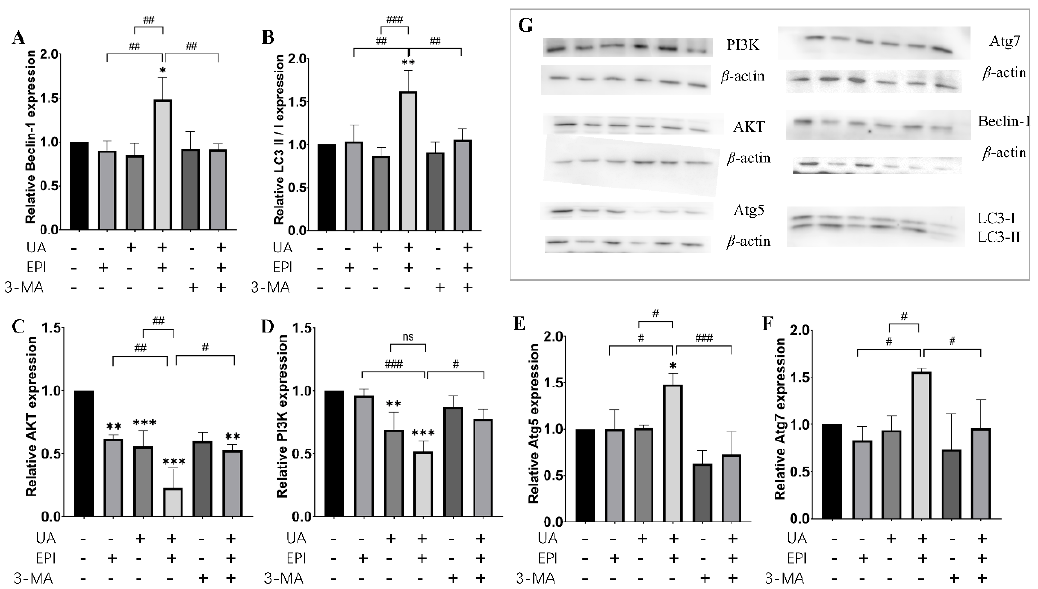
Figure 7. Changes in the expression levels of autophagy-related protein in MDA-MB-231 cells. West- ern blot analysis was used to measure autophagy-related protein expression levels in MDA-MB-231 cells. ( A ) Quantification of Beclin-1 protein expression levels in MDA-MB-231 cells. ( B ) Quantification of LC3-II/I protein expression levels in MDA-MB-231 cells. ( C ) Quantification of AKT protein expression levels in MDA-MB-231 cell. ( D ) Quantification of PI3K protein expression levels in MDA-MB-231 cells. ( E ) Quantification of Atg5 protein expression levels in MDA-MB-231 cells. ( F ) Quantification of Atg7 protein expression levels in MDA-MB-231 cells. ( G ) Representative pictures of Beclin-1, LC3-II/I, AKT, PI3K, Atg5, Atg7 expression by Western blot. The means and SEM were shown. n = 3. * p < 0.05, ** p < 0.01 and *** p < 0.001 versus control group in the absence of any treatments; # p < 0.05, ## p < 0.01 and ### p < 0.001. The value bars with ns are not significant.